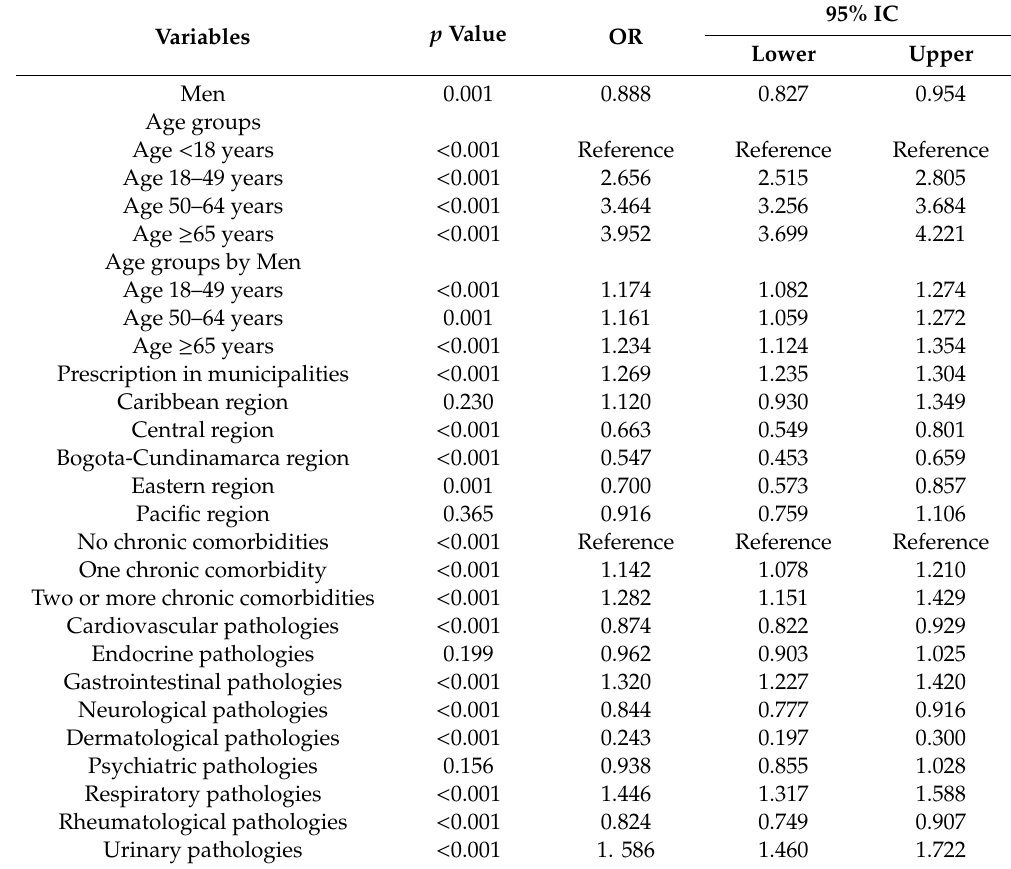
Table 5. Multivariate analysis of the variables associated with the prescription of Watch and Reserve antibiotics in the study sample from Colombia, January,